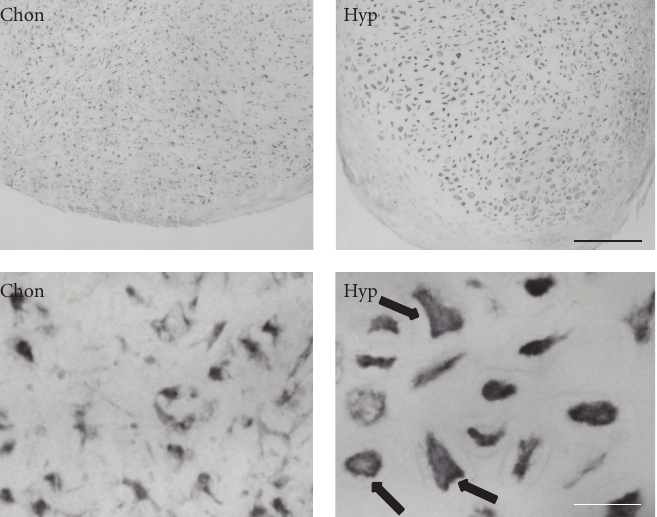
Figure 4: Immunohistochemistry for BAMBI. BAMBI staining is increased under hypertrophic conditions compared to chondrogenic conditions. Pronounced staining at cell membranes is detected especially under hypertrophic conditions (black arrows). Black scale bar = 200 𝜇 m; white scale bar = 50 𝜇